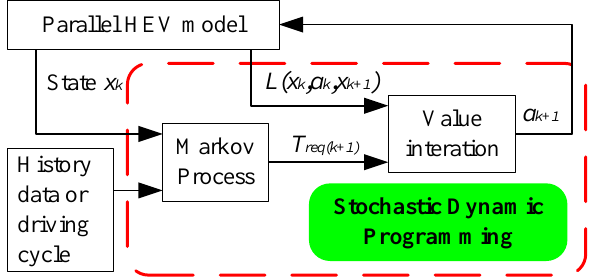
Figure 3. Overall schematic diagram of the SDP approach.